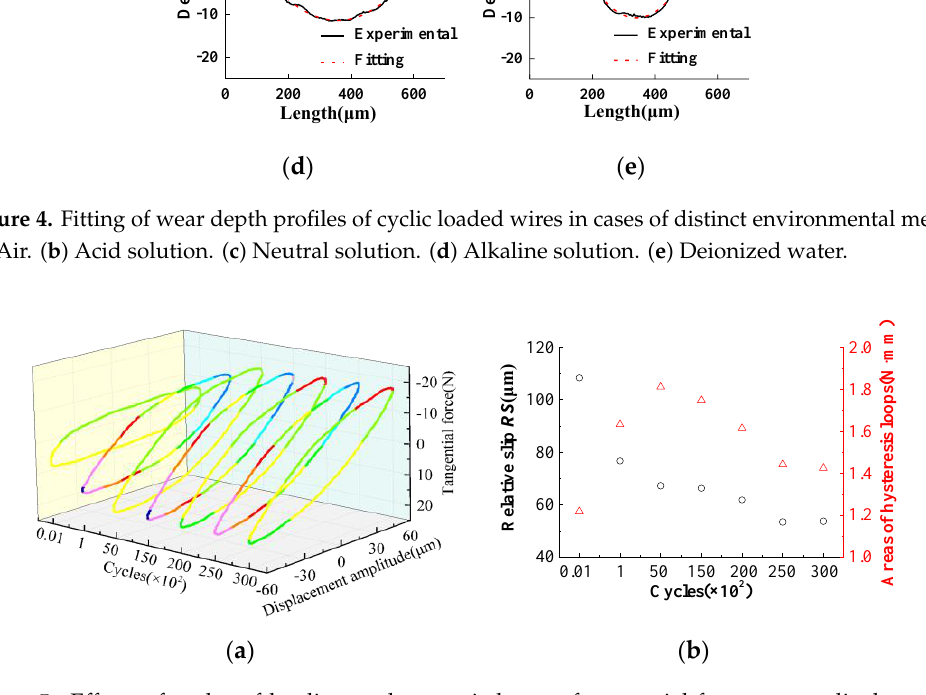
Figure 5. Effects of cycles of loading on hysteresis loops of tangential force versus displacement amplitude and the relative slip. ( a ) Hysteresis loops. ( b ) Relative slip and hysteresis loop area.